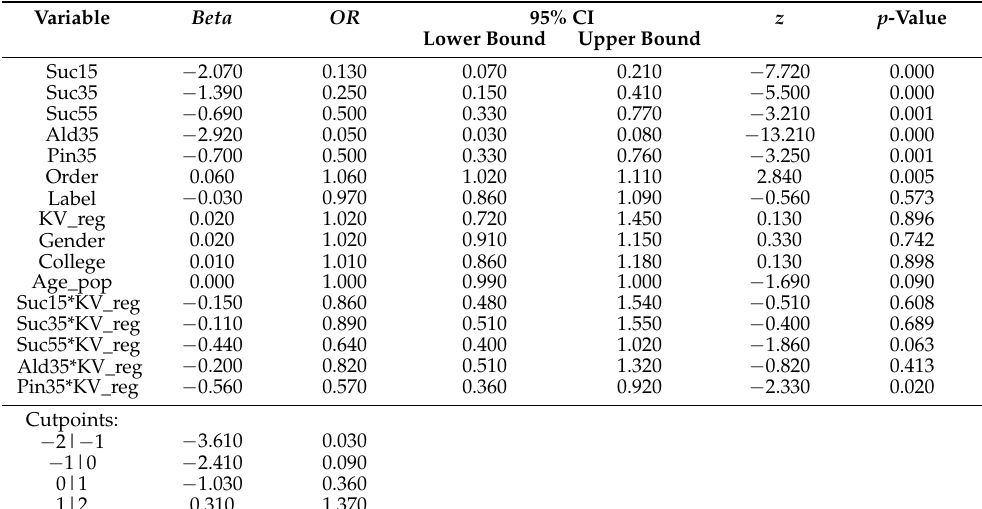
Table 3. Ordinal logistic regression